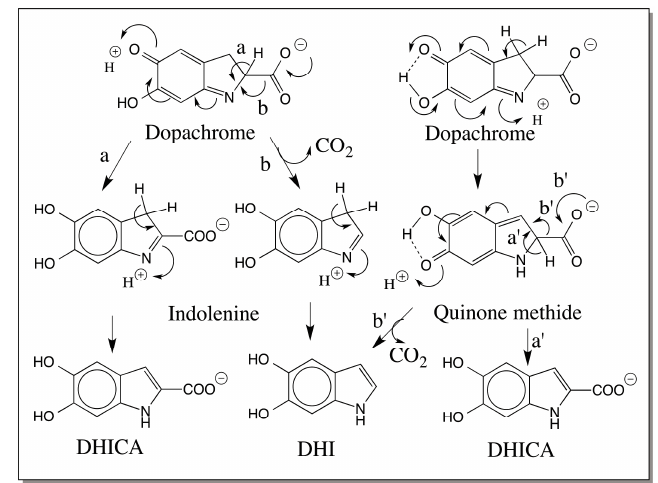
Figure 3. Two possible routes for the conversion of dopachrome. Dopachrome can undergo either